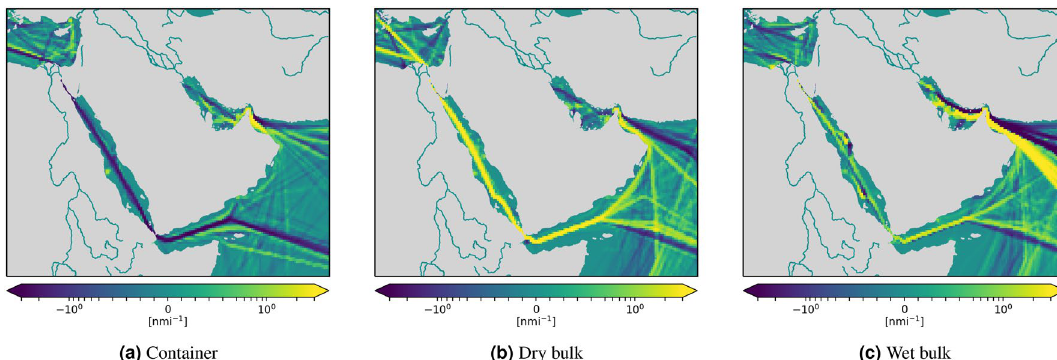
Figure 7. Monthly CNM density difference in the area around the Suez Canal between 2020 and 2019 for container ( a ), dry ( b ) and wet bulk ( c ) shipping. The considered time period is from 13 March to 13 April. Each grid cell is colored based on the variation of the 2020 value with respect to 2019, ranging from dark purple, which represents a decrease of CNM in 2020 with respect to 2019, to bright yellow, which represents an increase of navigated miles in 2020 with respect to the previous